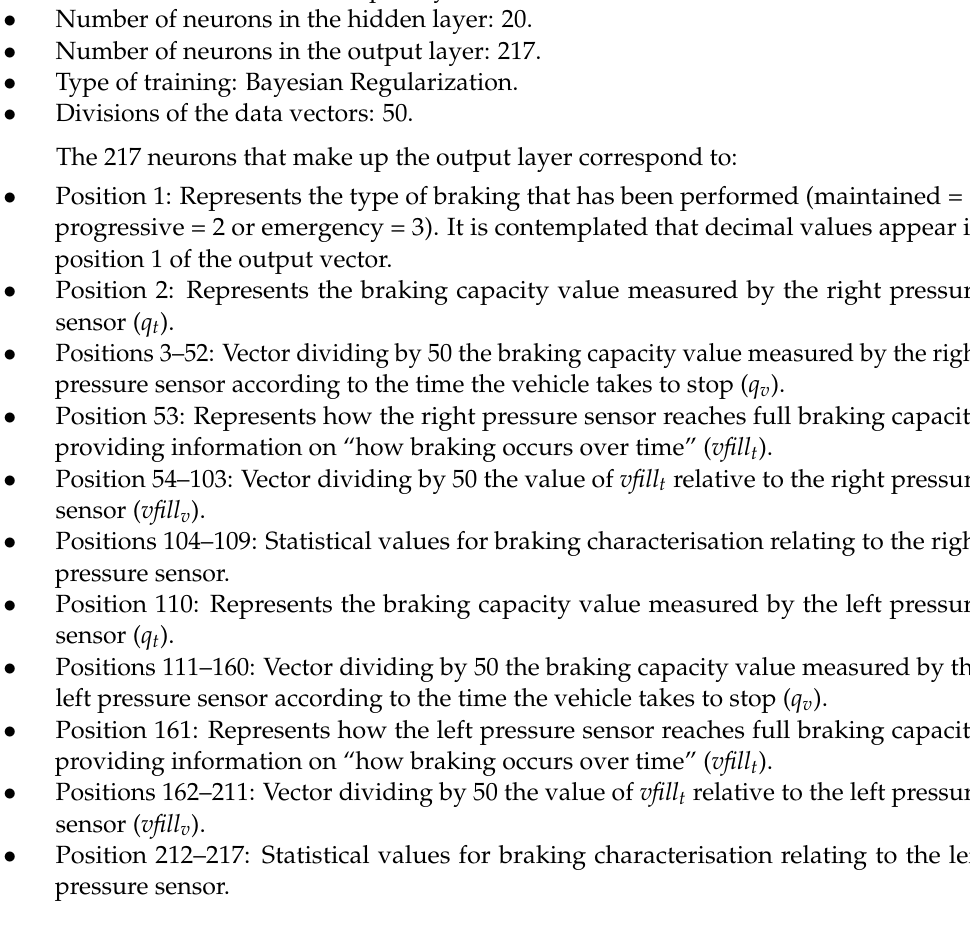
Figure 14. Architecture of the chosen ANN.